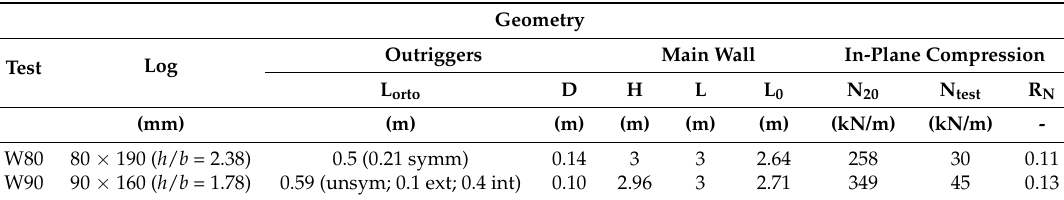
Figure 1. W80 log-house timber wall with ‘standard’ carpentry joints: ( a ) nominal geometrical properties and ( b , c ) specimen photos, during the assembly stage (( b ) corner detail, ( c ) view of the full specimen, from the top). Table 1. Reference geometrical and mechanical features for the partially insulated W80 specimen, as compared with the unprotected W90 sample reported in